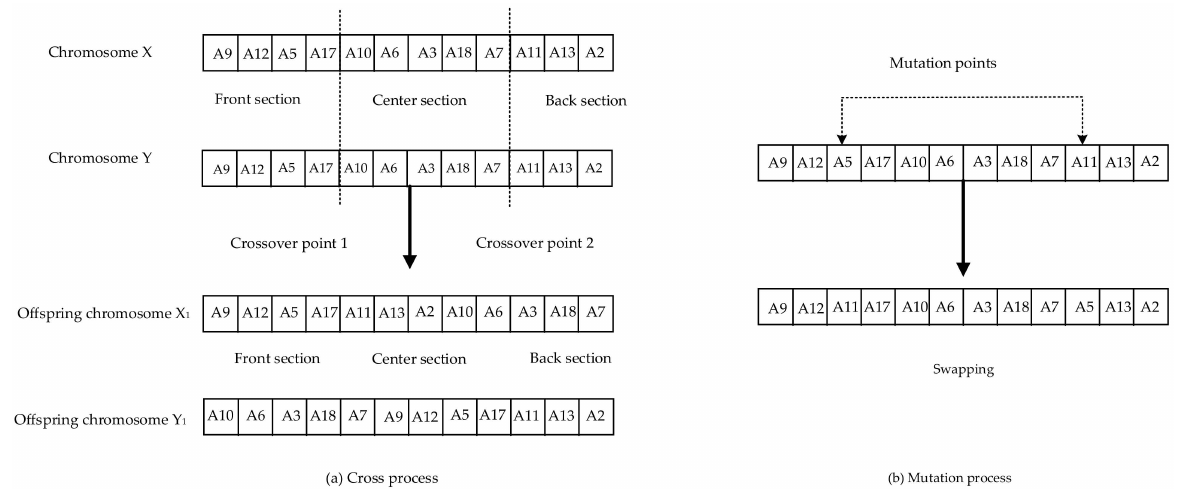
Figure 4. Examples of crossover and